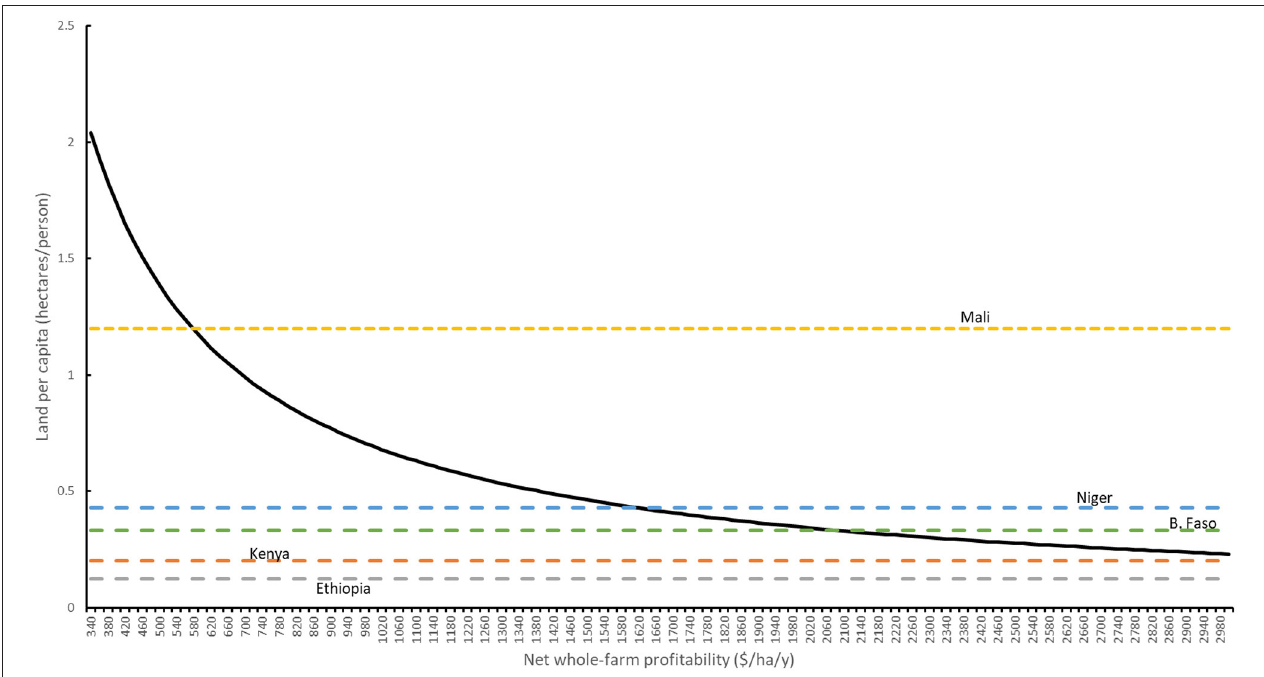
FIGURE 4 | Combinations of land per capita and net whole-farm profitability that will generate an income of $1.90 per person per day. Horizontal lines are the median per capita values for the five country